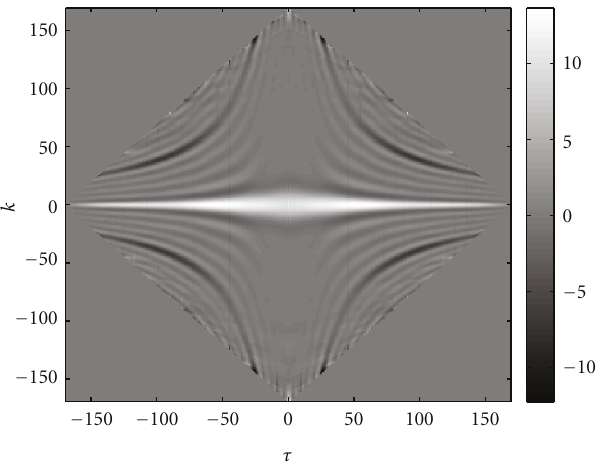
Figure 6: Left: Wigner distribution of HRV data. Right: Wigner spectrum of the estimated covariance